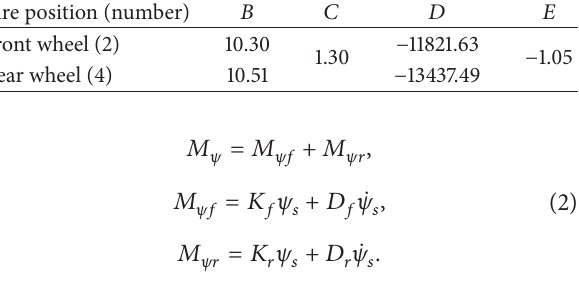
Table 1: Curve factors’ values of nonlinear tire. Tire position